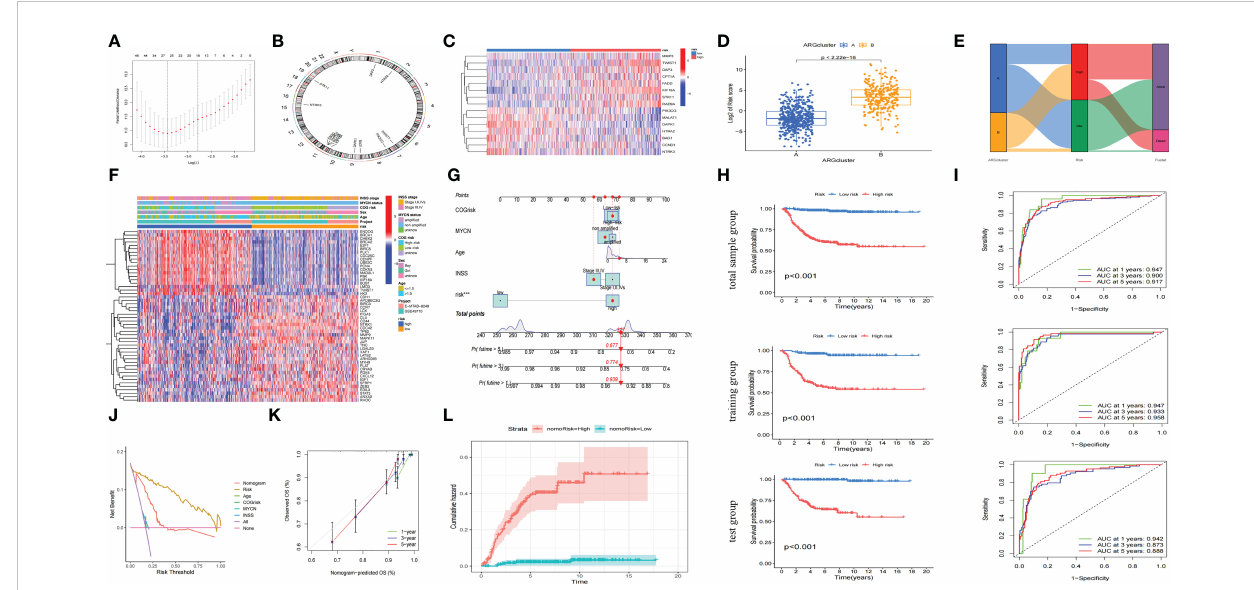
FIGURE 5 Construction of an accurate anoikis-related model. (A) 26 key genes screened through further cross-validation (alpha=1). (B) The locations of 15 genes in chromosomes obtained by multivariate cox regression analysis. (C) Heatmap of the distribution of the 15 genes involved in model construction between the high riskscore and low riskscore groups. (D) Boxplot of riskscore distribution of samples in different ARClusters. (E) Alluvial diagram of subtypes and living status. (F) Heatmap of clinical information and differentially expressed Args between two risk subgroups. (G) Nomogram of the commonly used clinical indicators and the risk level calculated by anoikis-related model. (H) OS analysis of two risk subgroups in the total sample group, training group and test group. (I) The time-dependent ROC curves for OS at 1-, 3-, and 5-years in the total sample group, training group and test group. (J) Net bene fi t (y-axis) as calculated are plotted against the threshold probabilities of patients having 5-year survival on the x-axis. (K) Calibration curve of OS at 1-, 3-, and 5-years for the anoikis-related model in the total sample group. (L) . Cumulative hazard curve represented the probability of survival risk with the prolongation of survival time. ***, p < 0.001.